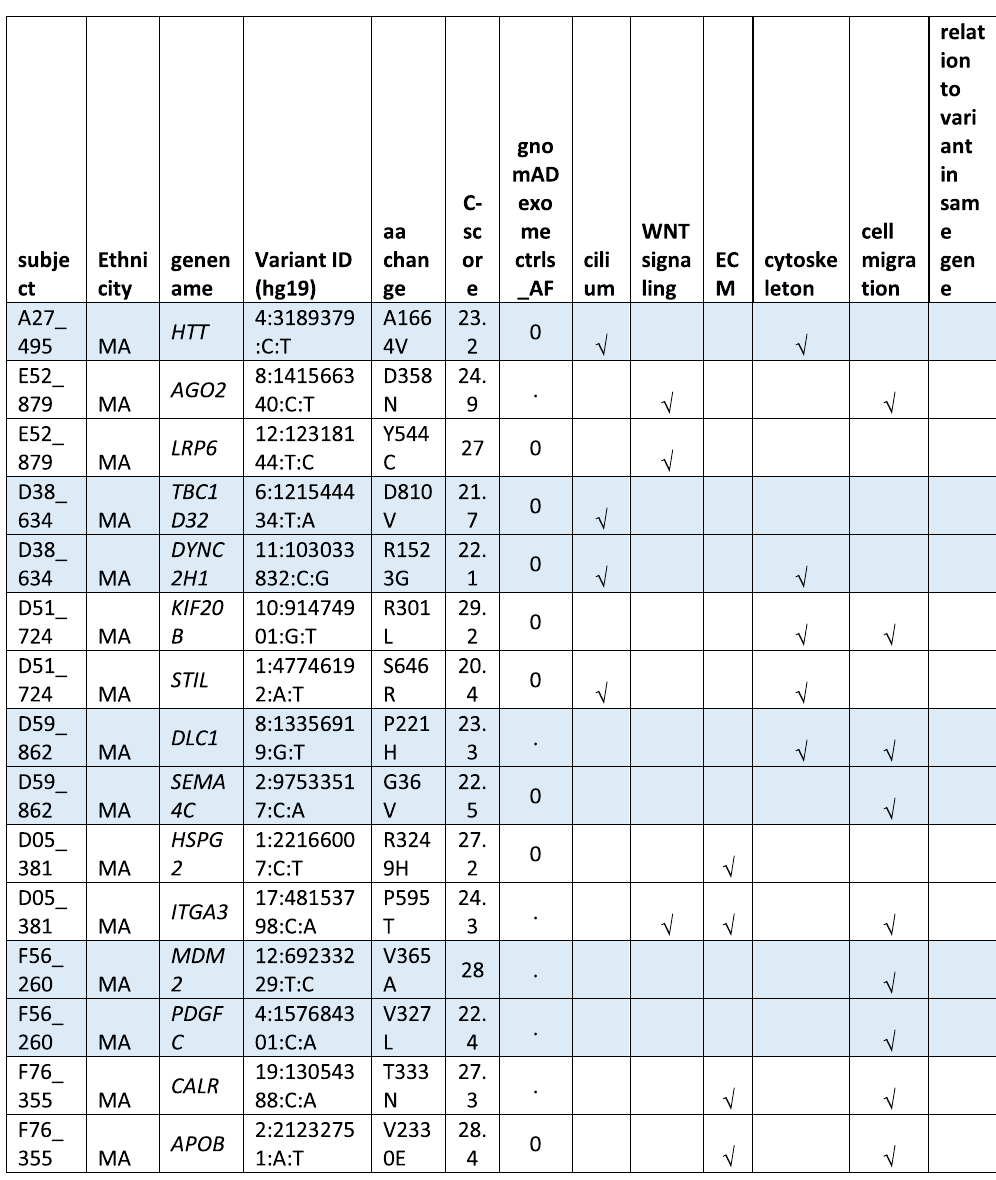
Table 2. Subjects with multiple URDVs in candidate genes classified with one or more ontological groups. Note: EA—European American subjects, MA—Mexican American subjects. URDV—ultra-rare deleterious single nucleotide variant defined in Materials and Method section. Gene name—is the symbol of gene recommended by the Human Genome Organization Gene Nomenclature Committee (HGNC). Gene assigned into cilium, WNT-signaling, extracellular matrix (ECM), cytoskeleton and cell migration was described in Materials and Methods, and Supplementary Table 3. C-Score—Combined Annotation Dependent Depletion (CADD) score is a broadly applicable metric that objectively weights and integrates diverse information that integrates multiple functional annotations into one metric by contrasting variants that survived natural selection with simulated